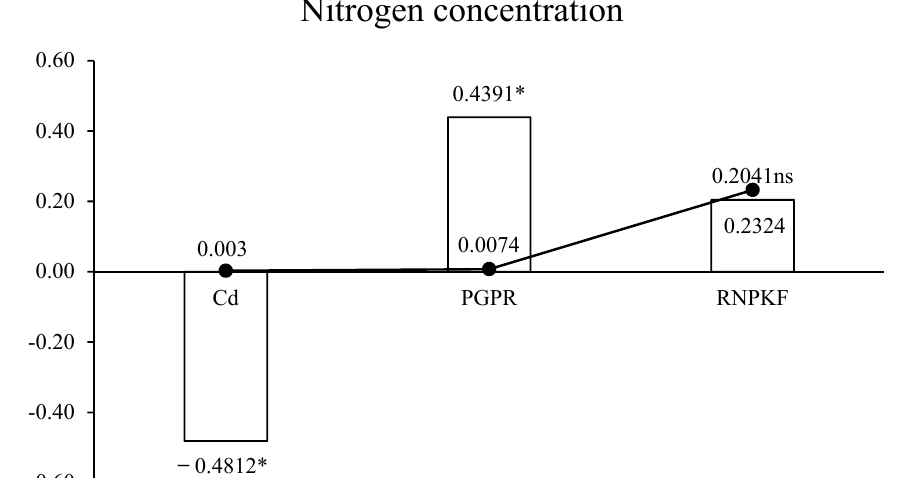
Figure 10. Pearson correlation of Cd, PGPRs, and RNPKF for bitter gourd nitrogen concentration (NB) * = significant ( p ≤ 0.05); ns = non ‐ significant.